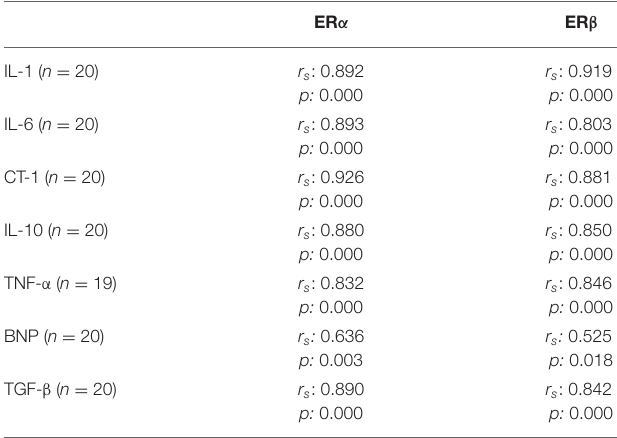
r s ,Spearmanrankcorrelationcoefficient.BNP,brainnatriureticpeptide;CT,cardiotrophin; ER, estrogen receptor; IL, interleukin; TNF, tumor necrosis factor; TGF, tissue growth